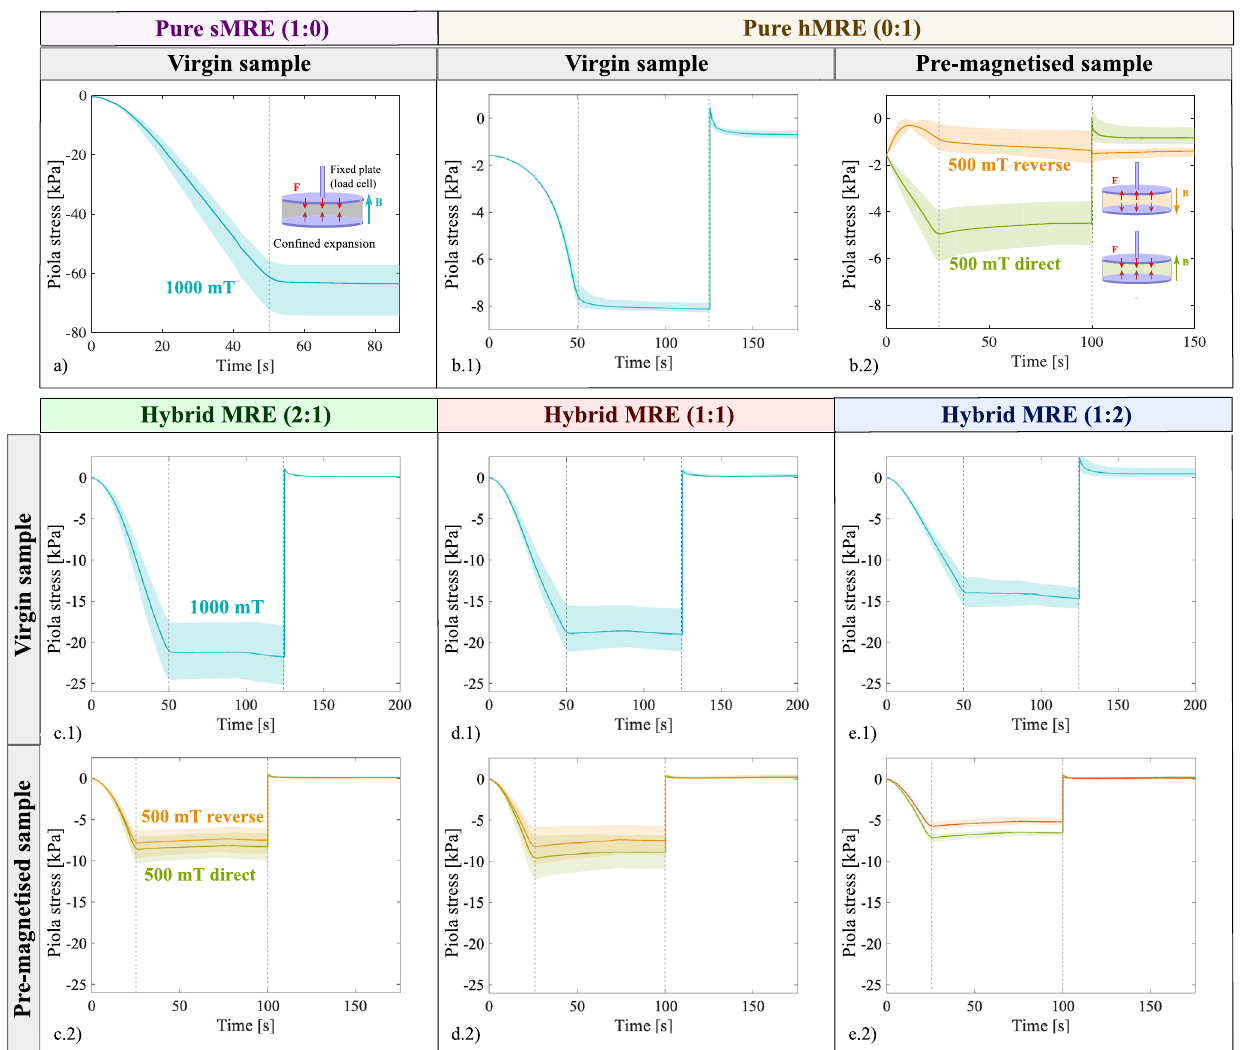
Fig. 2 Macrostructural evaluation of microstructural magneto-mechanical interactions. Time evolution of the axial stress (Piola stress) exerted by mechanically con fi ned samples on the upper plate of the rheometer for multiple soft-to-hard-magnetic particles mixing ratios of a 1:0, b 0:1, c 2:1, d 1:1, e 1:2. The experiments are conducted on virgin and pre-magnetised samples. The magnetic fi eld on virgin samples is applied until reaching a maximum of 1000 mT, then kept constant for 75 s and fi nally switched off. On the pre-magnetised samples,